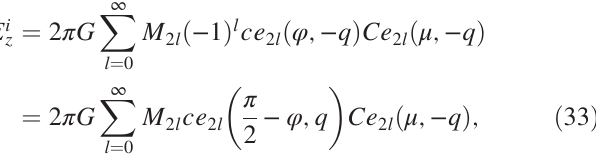
FIG. 2. Comparison between the Green ’ s function in free space computed with Eq. (25) (blue line) and Eq. (32) (red dashed line) with 120 summation terms, as a function of the radial coordinate and φ ¼ 0 , for a focal distance F ¼ 1 .